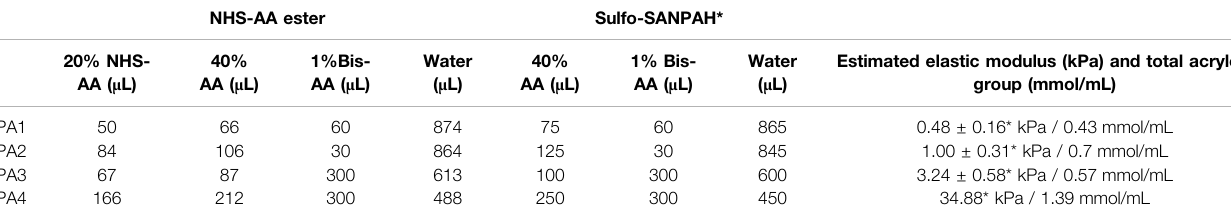
TABLE 2 | Recipe of polyacrylamide using NHS-AA ester and sulfo-SANPAH as protein crosslinker. NHS-AA ester